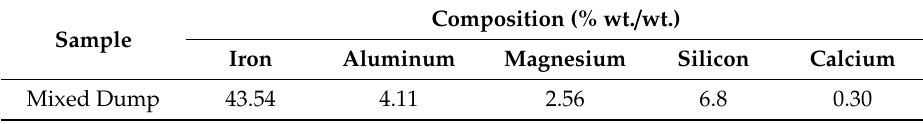
Table 4. Elemental composition of the mixed dump sample as analyzed through ICP-OES.